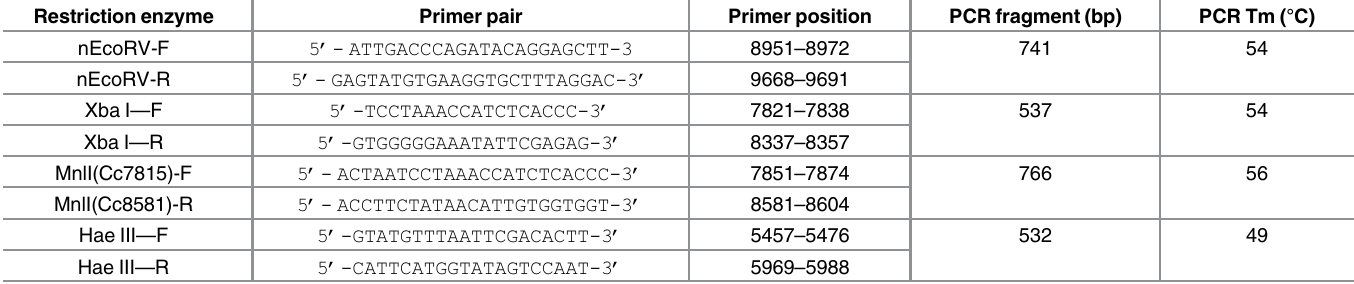
Table 3. PCRs for determining mitochondrial medfly haplotypes through PCR-RFLP tests, primer sequences and binding sites, size of expected amplicon and annealing temperatures, along with respective restriction enzymes are indicated. Restriction